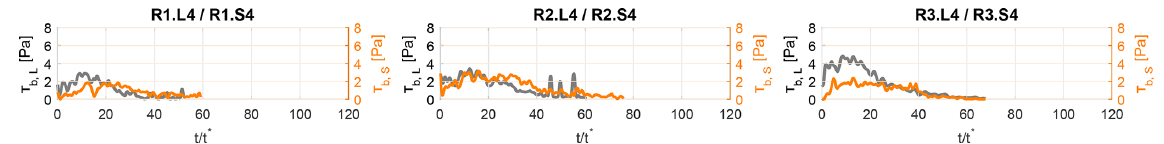
Figure 8. Temporal evolution of bed shear stresses calculated by log-law fitting for tests with progressively reduced lock length ( τ b , L ) and with the lock slope ( τ b , S ).